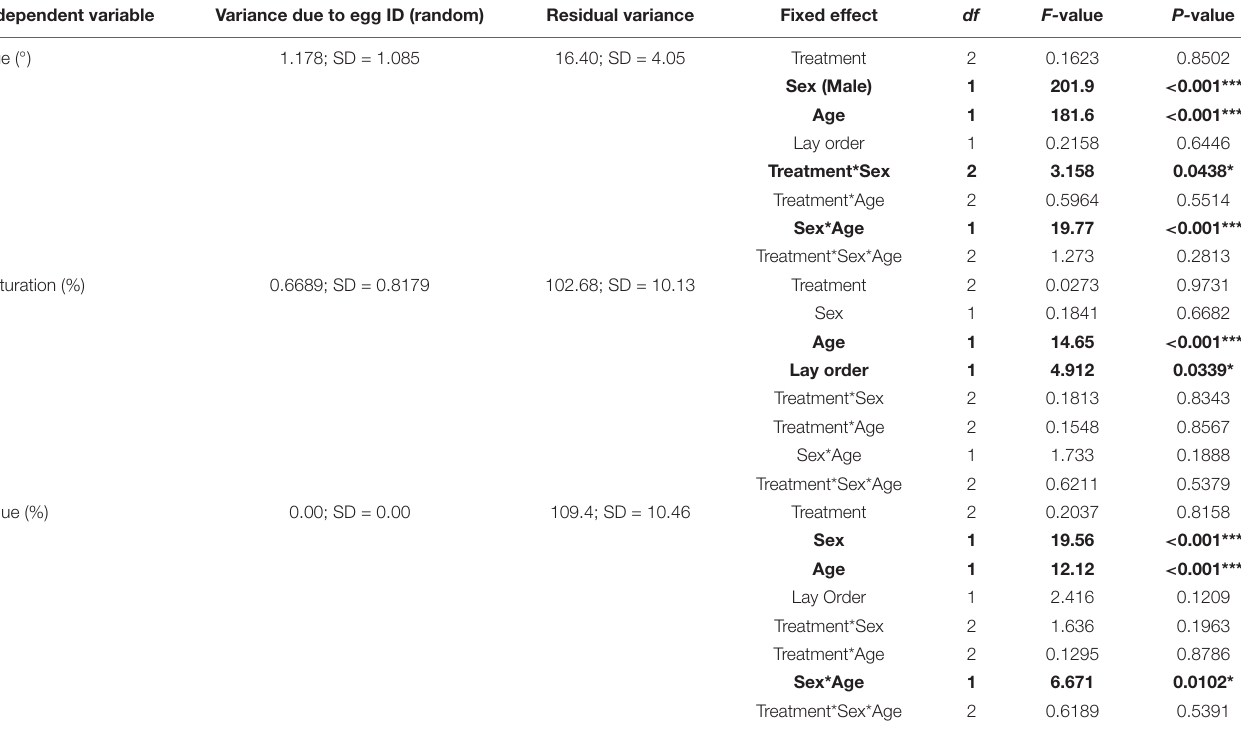
TABLE 1 | Statistical summary of effects of incubation temperature on beak color before and after sexual maturity (Aim 1) using a global linear mixed effects model. Independent variable Variance due to egg ID (random) Residual